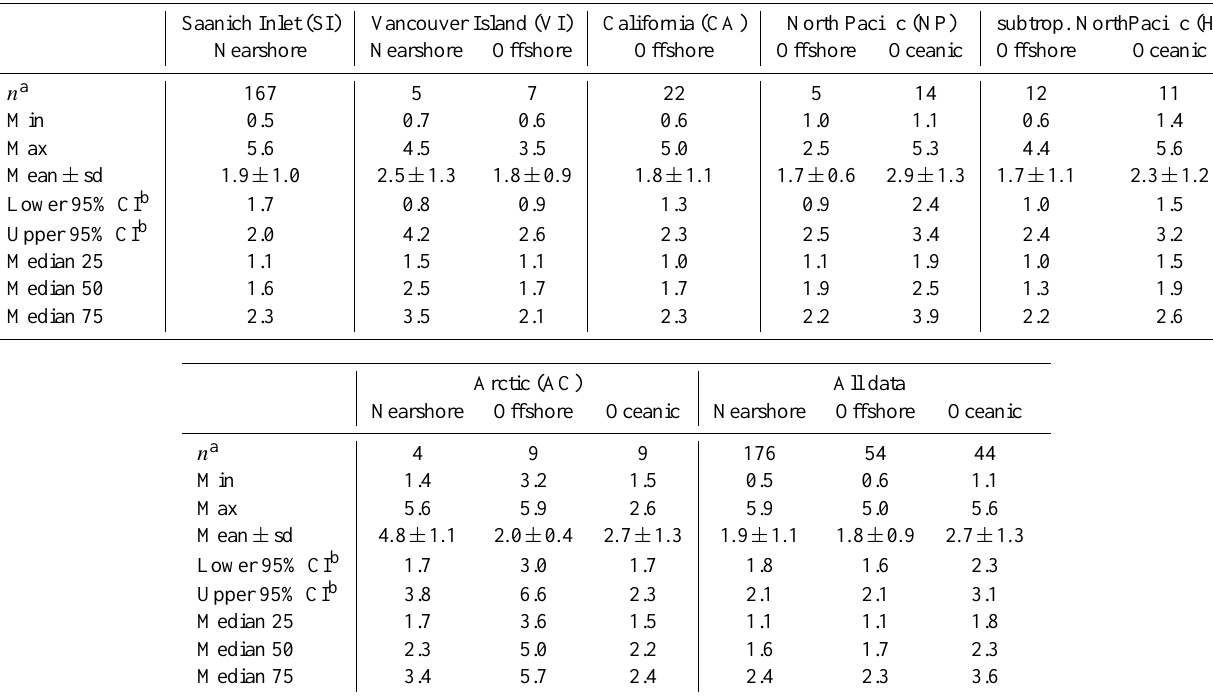
Table 3. Statistical data on enrichment factors of surfactants in the microlayer at different study areas.